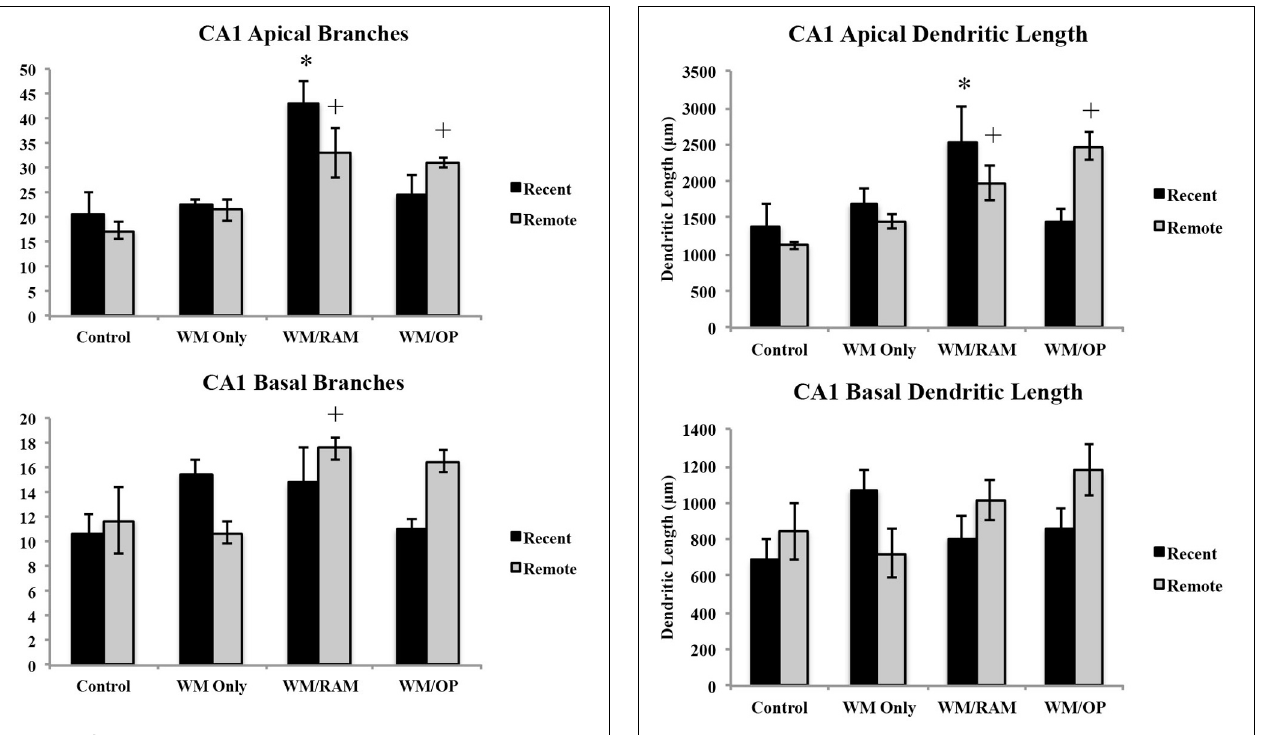
FIGURE 10 | Total dendritic length in the CA1 in apical and basal dendrites. Only significant differences between behavioral groups and their respective control group are displayed. Refer to Results section for all comparison results. ∗ Significantly different from Control:recent group ( p < 0 . 05); + Significantly different from Control:Remote ( p < 0 .